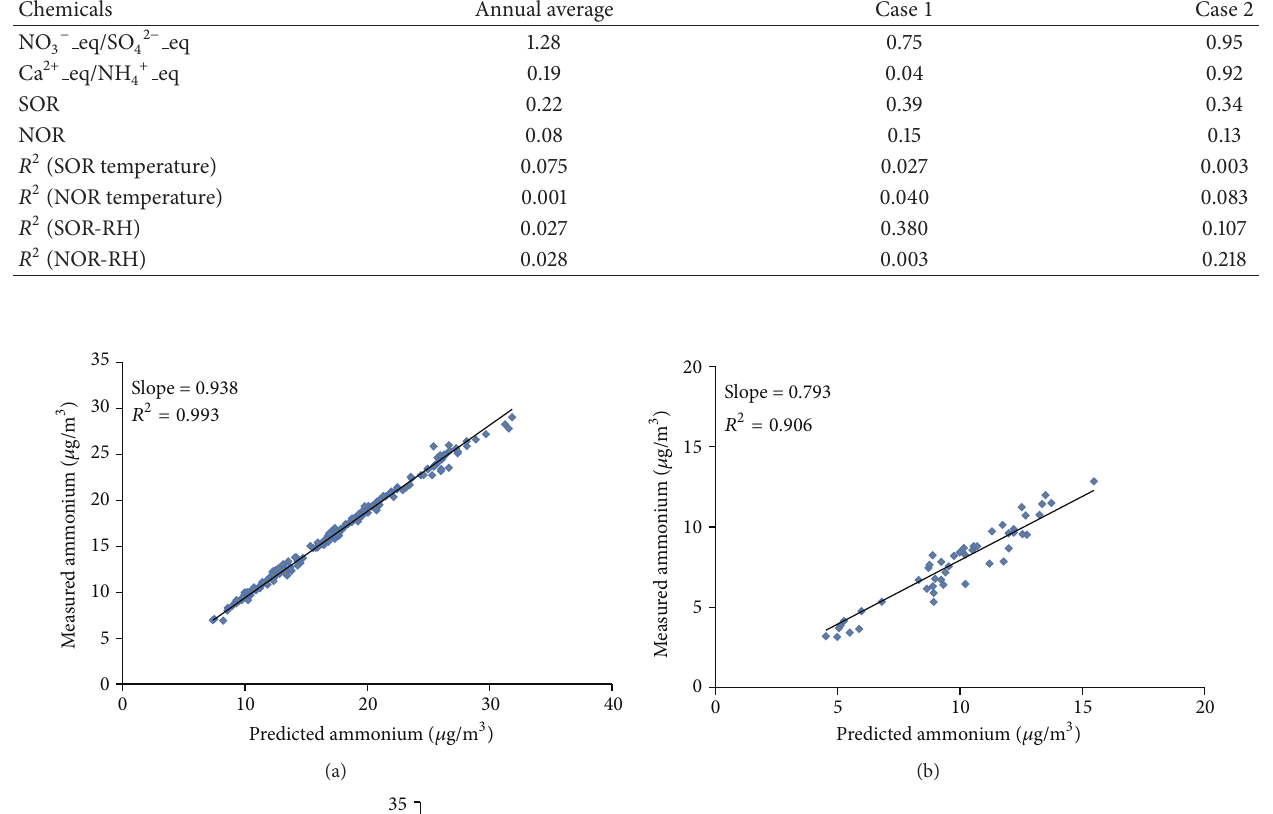
Table 3: Several indicators for acidic condition and oxidation state of atmosphere.